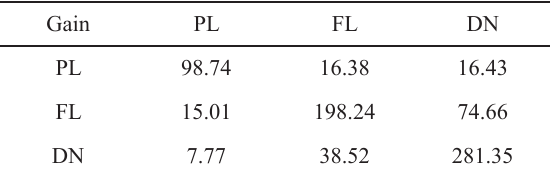
Direct gain (g/selection generation) in the main diagonal and indirect gains (g/selection generation) above and below this diagonal.